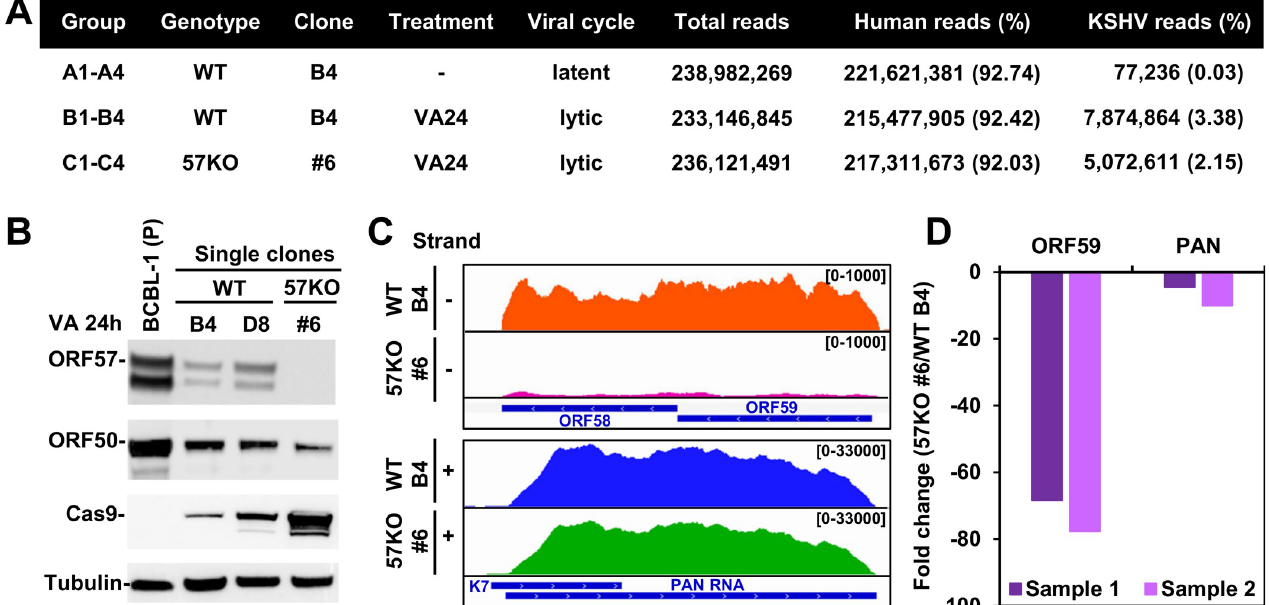
Fig 1. Viral gene expression in BCBL-1 single-cell clones. (A) Samples used for RNA-seq including WT single-cell clone B4 of BCBL-1 cells carrying Cas9 vector lacking gRNAs expression and 57KO single-cell clone #6 carrying a plasmid expressing gRNA2+4 (pABC8) described in previous studies [21]. Total RNA from uninduced clone B4 cells representing WT cells with latent infection (4 samples, A1-4), clone B4 cells treated with 1 mM valproic acid for 24 h (VA24) representing the WT cells with the lytic infection (4 samples, B1-4), and clone #6 cells treated with 1 mM valproic acid for 24 h (VA24) representing the 57KO cells with the lytic infection (4 samples, C1-4) were subjected to RNA-seq. Total RNA-seq reads uniquely mapped to the human (hg38)/KSHV (GenBank Acc. No. HQ404500) chimeric genome were counted in each group of four samples. (B) Relative protein expression of ORF57, ORF50, and Cas9 in parental BCBL-1 (P) and BCBL-1 single-cell clones containing a wild-type genome (WT clones B4 and D8) or an ORF57-null genome (57KO clone #6) under 24 h of KSHV lytic infection induced by 1 mM valproic acid (VA 24h). Immunoblot was performed with each protein corresponding specific antibody, with β -tubulin serving as a protein loading control. (C) RNA-seq reads-coverage of KSHV ORF58-59 and PAN RNA loci in one representative sample each from WT B4 and 57KO #6 cells with KSHV lytic infection induced by 24 h VA treatment. The numbers in the upper right corner represent the reads-coverage depth. (D) Validation of PAN and ORF59 RNA expression from WT B4 and 57KO #6 cells by RT-qPCR. Total RNA from WT B4 and 57KO #6 cells with KSHV lytic infection described in panel C was used for the assays.